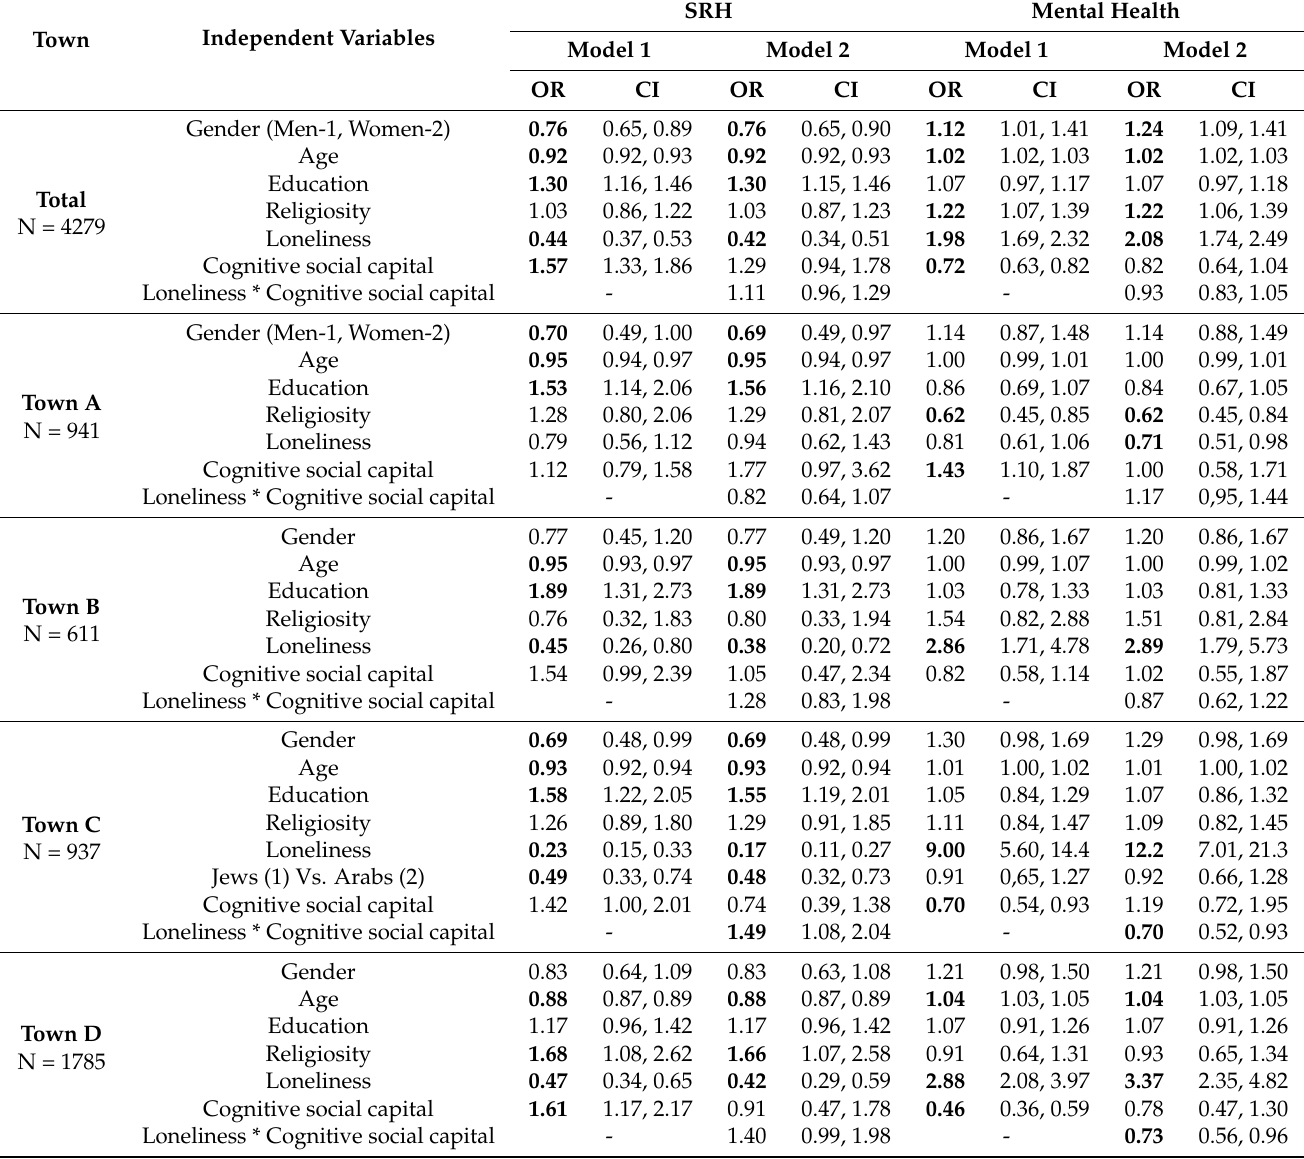
Table 5. Variables associated with self-rated health (SRH) and mental health, including cognitive social capital. Logistic regressions presenting odds ratio (OR) and confidence intervals